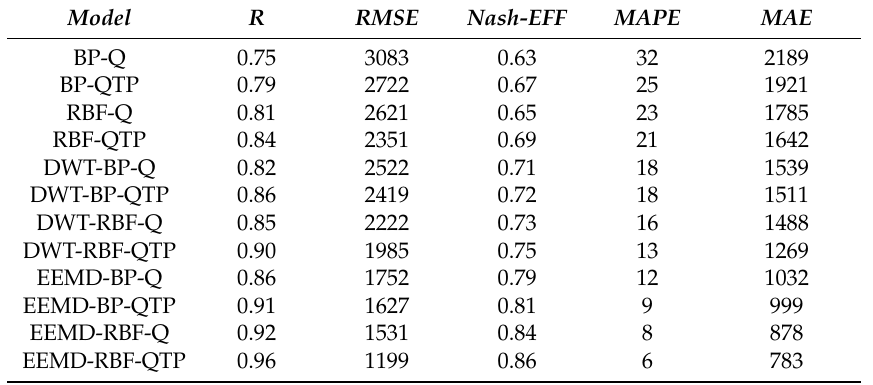
Table 8. Performance evaluation of the applied models for zone two during the calibration period.